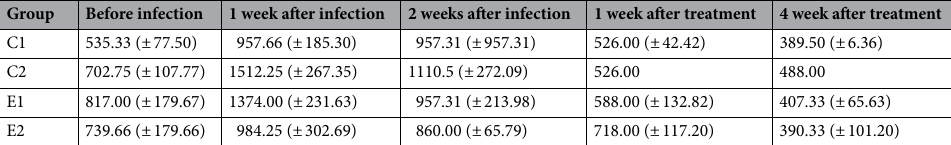
Table 5. Results of ALP changes. The changes are depicted as mean ± standard deviation (SD).